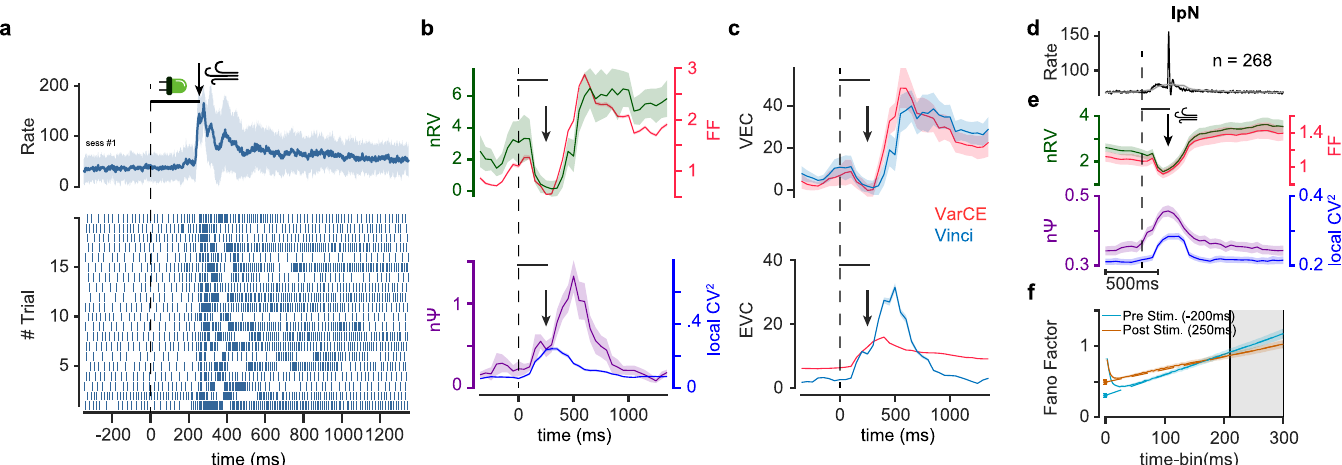
Fig 3. Post-stimulus changes in rate variability and enhancement of spiking irregularity in cerebellum. (a) Example IpN neuron PSTH with standard deviation as the shaded area (top) and raster plot of 20 example trials (bottom) aligned to the conditioned stimulus (CS) onset (LED light) followed by unconditioned stimulus (US, air- puff) in 250ms. (b) Post-stimulus FF and nRV showing an initial decrease followed by sustained increase (top) and post-stimulus n C showing a robust increase (bottom). also shows a moderate increase following stimulus onset. (c) VEC and EVC estimations using the Vinci vs VarCE method (top and bottom, respectively). VarCE CV 2 local overestimates the rise in VEC (related to rate variability) and underestimates EVC (related to spiking irregularity). (d) Average PSTH of IpN neural population (n = 268) neurons. Black and gray traces show PSTHs with 10ms and 300ms bin-widths, respectively. 300ms bin-width is equal to time-bin used for variability estimation in the (bottom) as a function of time within the sliding time-bin (300ms, 50ms sliding). Dashed line Vinci and FFA methods. (e) Average FF and nRV (top) and n C and CV 2 local indicates CS onset, horizontal line indicates CS on period and arrow indicates US onset. (f) FF as a function of time-bin centered on pre- and post-stimulus onset periods (-200 and 250ms respectively). Gray area indicates the linear zone at which asymptotic FF is estimated. The increase in intercept and the decrease in slope is consistent with changes in n C and nRV respectively. Error bars and shades are sem.